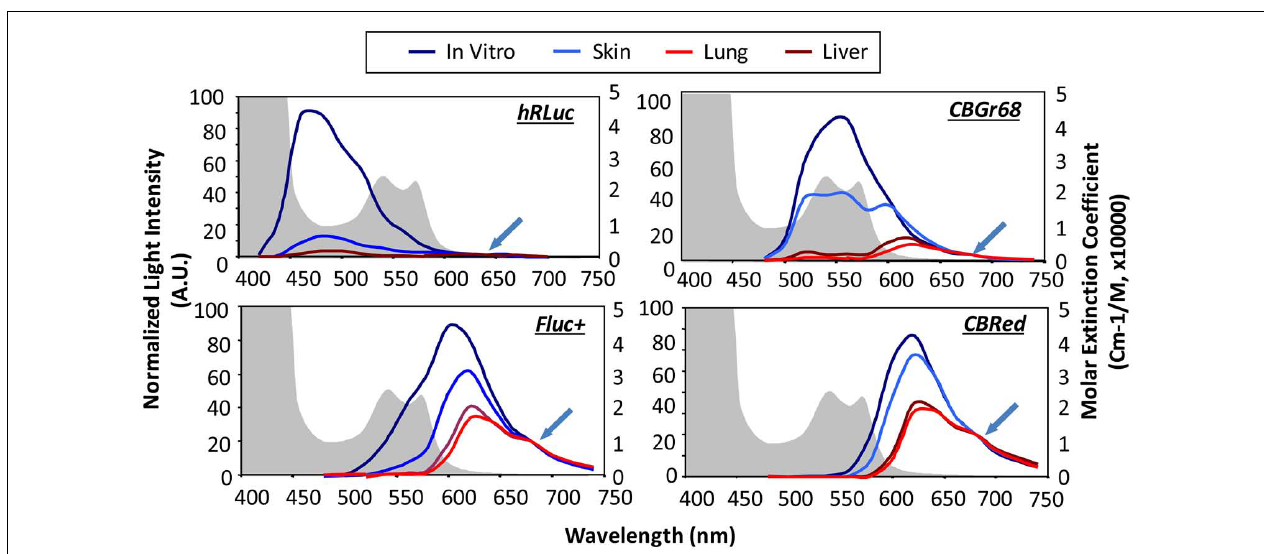
FIGURE 6 | In vivo emission spectra of bioluminescent reporters. Emission spectra from luciferase expression in skin, lung, and liver are compared with those from labeled cells in culture showing tissue-induced light attenuation in the blue spectrum. Photon fluxes are normalized to the values at 680 nm for beetle luciferases and 640 nm for Renilla